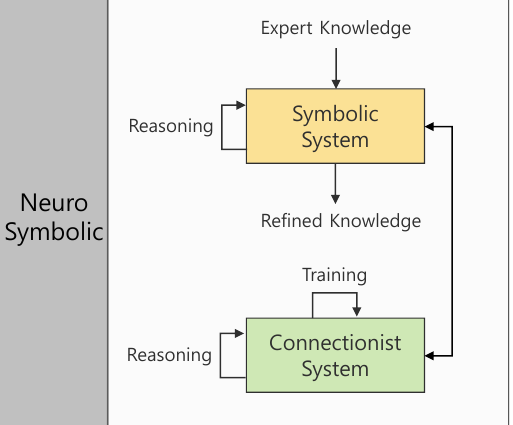
Figure 1. Neuro-symbolic approach: Connecting the symbolic system which outputs refined knowl- edge by reasoning the expert knowledge input in a symbolic representation format with the connec- tionist system which